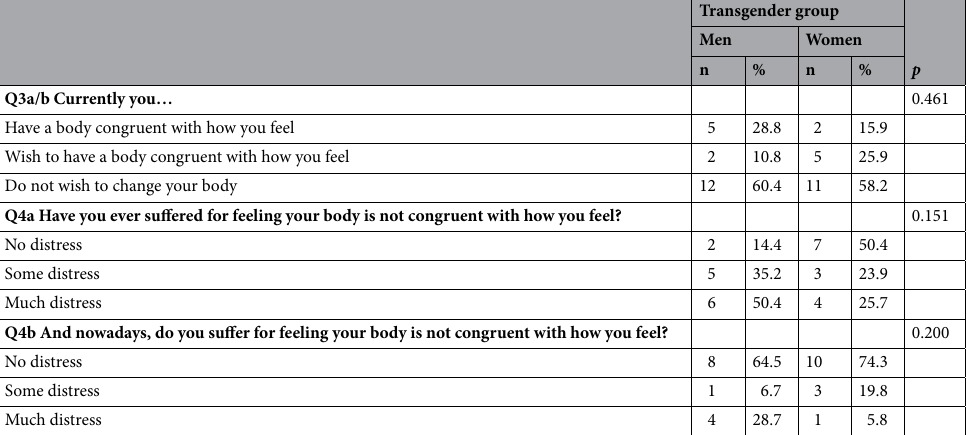
Table 3. Perception of and distress due to gender-related body characteristics in transgender individuals. All percentages were design-adjusted. Only individuals who answered the questions were included in the analysis (i.e., those who refused to answer or reported not understanding the question were not